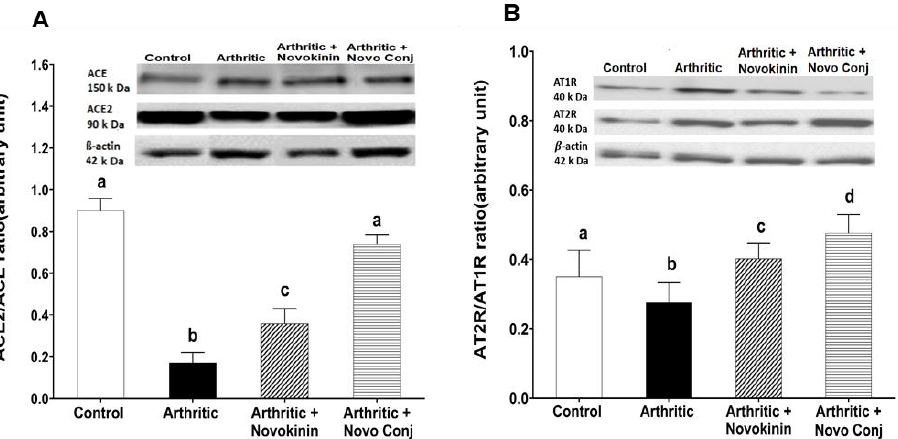
Figure 6. Novokinin conjugate (Novo Conj) increased protein expression of ( A ) angiotensin-converting enzyme 2 (ACE2)/angiotensin-converting enzyme (ACE1) and ( B ) angiotensin type II receptor (AT2R)/angiotensin type I receptor (AT1R) ratio in cardiac tissues. Mean ± standard deviation of the mean ( n =5 or 6). Triplicates samples were run. Data labeled with different letters (a, b, c, or d) indicate a statistical difference between groups where p < 0.05.